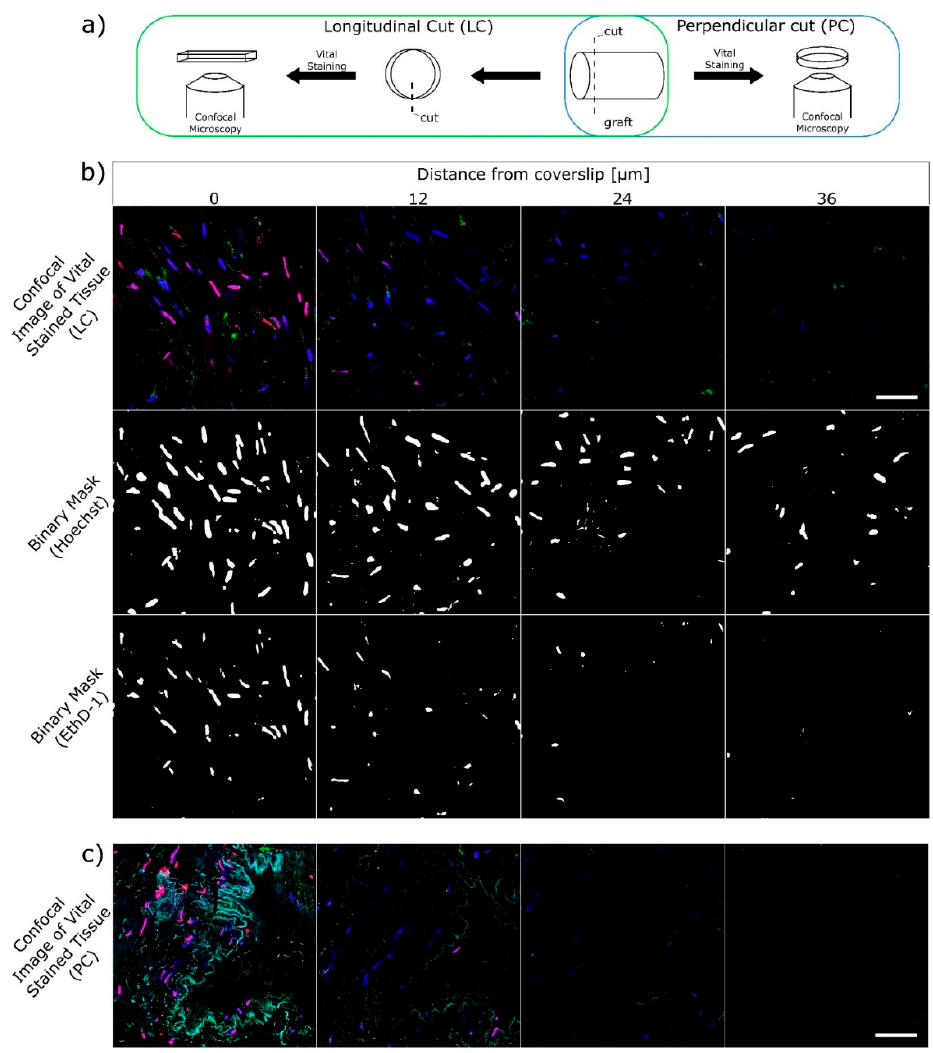
Figure 4. In situ staining of the thawed vascular graft sample with fluorescence vital dyes. ( a ) Scheme of the longitudinal (LC) and perpendicular (PC) cuts preparation. ( b ) Confocal images in four Z-planes for LC and subsequent binary masks used for automatic evaluation of viability. (Top) All cells in blue (Hoechst), dead cells in red (EthD-1), and enzymatic activity in green (calcein). (Middle and bottom) Comparison of dead cell count (EthD-1 mask) and total cell count (Hoechst mask). Scale bar 50 µ m. ( c ) Confocal images in color for PC. Note the internal cavity of the graft and majority of the cells on the “cut” side stained red. Scale bar 50 µ